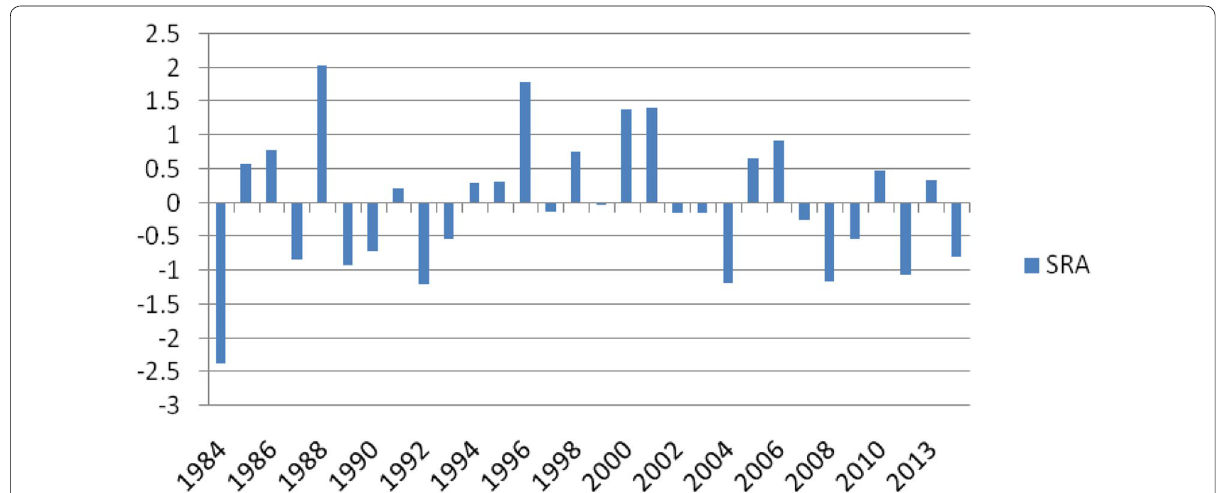
Fig. 4 Standardize Rainfall Anomaly (SRA) (1984–2014) the area (based on Ambamariam meteorological